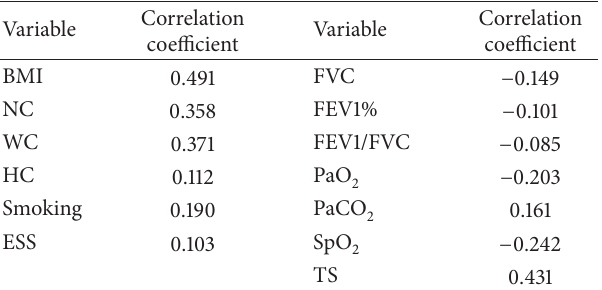
Table 2: Variables identified to be related to AHI in Spearman’s rho test and their correlation coefficients.